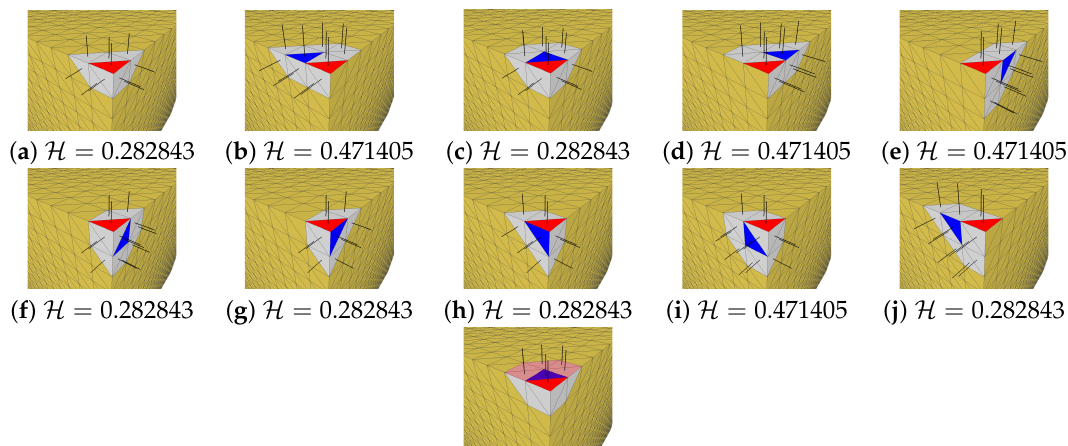
Figure 2. Patches construction and guidance normal calculation of the face of interest (red) located at the corner position. ( a – j ): The candidate patches of the GMNF method [5] and the consistency measure H . ( k ): We calculate the guidance normal in the selected patch (assumed to be ( c )) using our dual weight